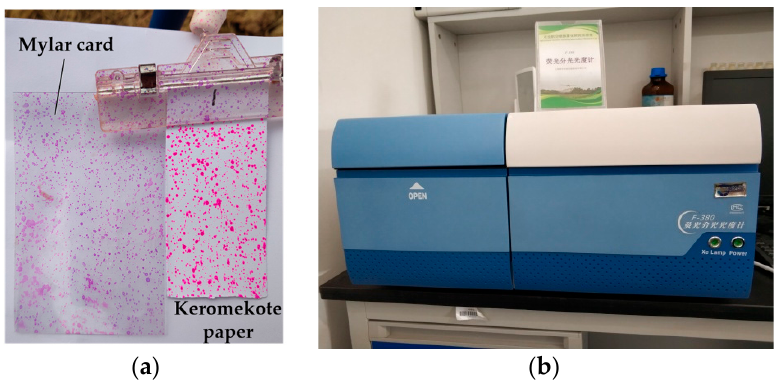
Figure 4. Data processing: (a) The collection of keromekote paper and Mylar card; (b) The fluorescence spectrophotometer